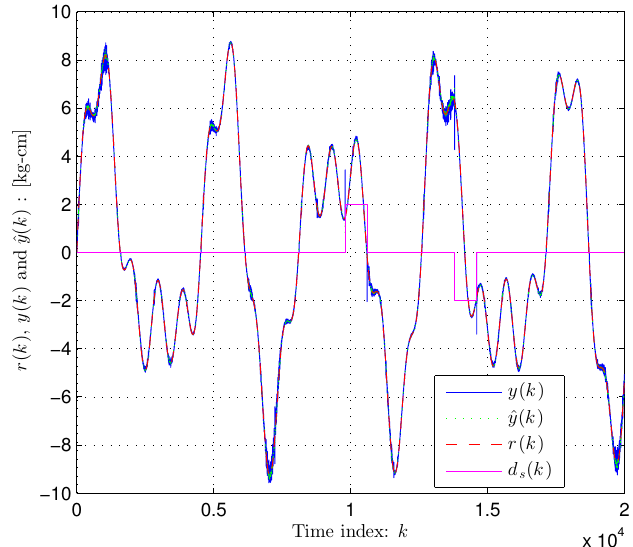
Figure 6. Tracking and model performance: with disturbance d s ( k ) .